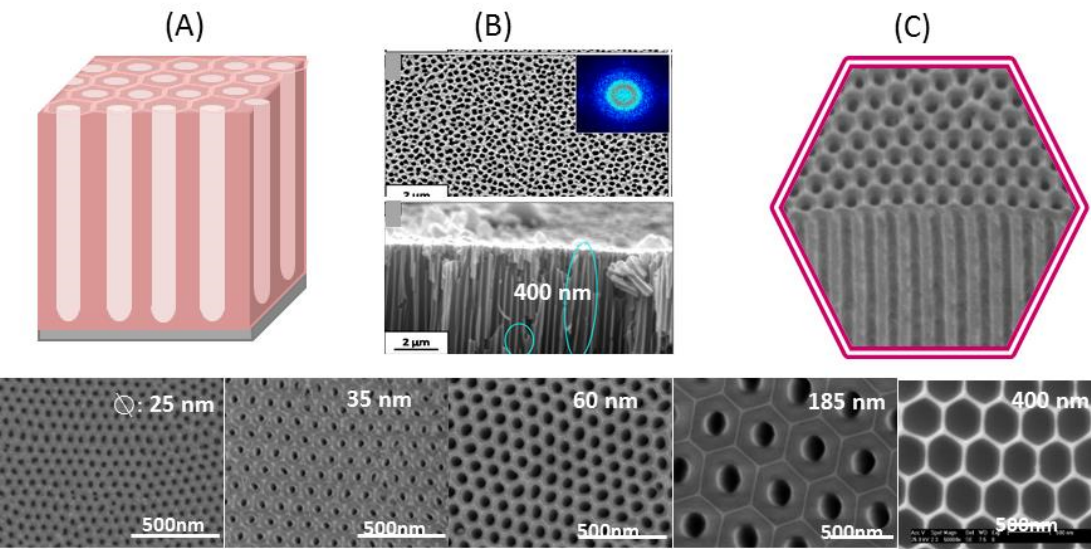
Figure 2. Top panels: Scheme of AAO templates ( A ); SEM images of a commercial ( B ) and a lab-made AAO template ( C ). Bottom panels: SEM images of top views of lab-made AAO templates with different pore diameters, from left to right: 25, 35, 60, 185 and 400 nm.